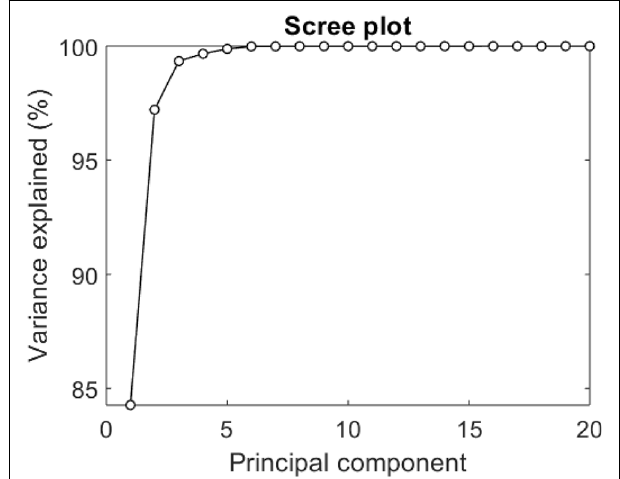
FIGURE 6 | Scree plot showing the cumulative variance explained by each additional principal component in the simulated data.